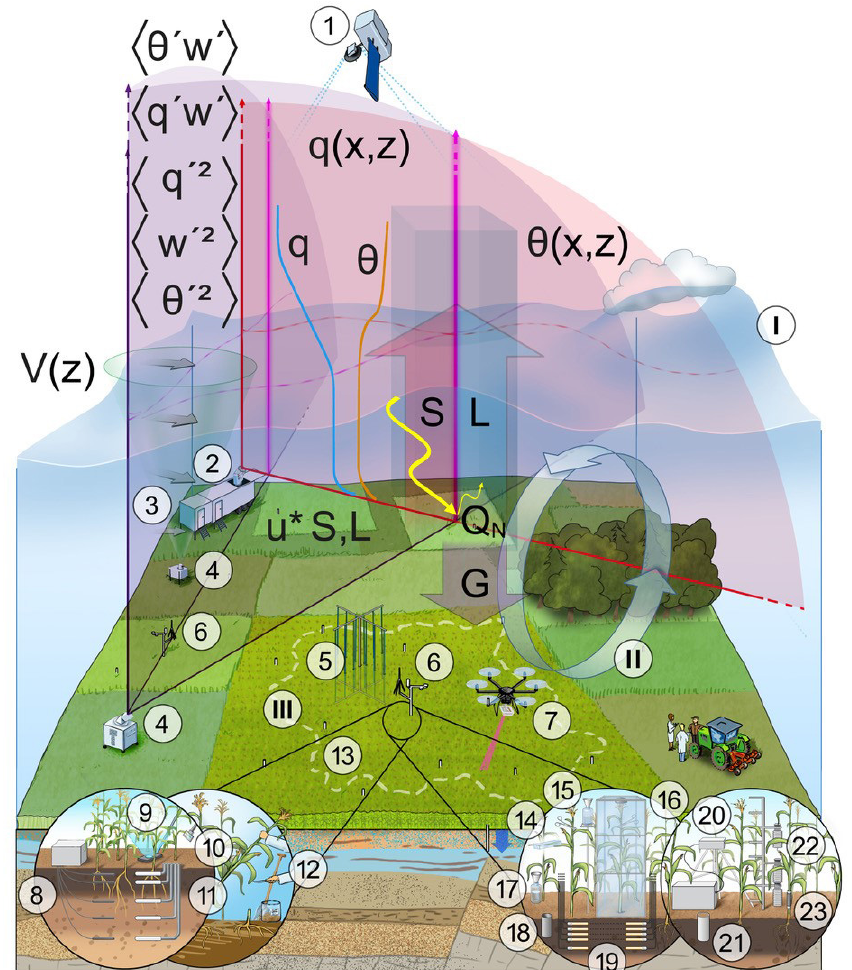
Figure 1. LAFO sensor synergy with the following elements labeled: (I) planetary boundary layer top; (II) mesoscale vortex; (III) flux foot- print; (1) satellite remote sensing; (2, 3, 4) vertically pointing and scanning Doppler, water vapor, and temperature lidar systems; (5) 3D fiber optic distributed temperature sensing (FODS) in combination with distributed wind and trace gas sensors; (6) energy balance and eddy covari- ance stations; (7) uncrewed aerial vehicle (UAV); (8) time domain reflectometers (TDRs); (9) leaf area index (LAI) measurement; (10) gas exchange system for photosynthesis and transpiration rate measurements; (11) tensiometers; (12) in situ crop measurements, such as root and shoot biomass, as well as canopy height; (13) soil moisture, temperature, and matric potential network; (14) leaf cuvette; (15) open rainfall sampler; (16) gas exchange chamber; (17) throughfall sampler; (18) groundwater well; (19) in situ soil water probes (14–19 are all coupled to a water isotope analyzer); (20) IR gas analyzer; (21) mini lysimeter; (22) canopy temperature, water vapor, and CO 2 profiles; and (23) sap flow sensors. For further explanations, see the GEWEX website (https://www.gewex.org/panels/global-landatmosphere-system-study-panel/ glass-projects/, last access: 19 January 2023) and Wulfmeyer et al. (2020).